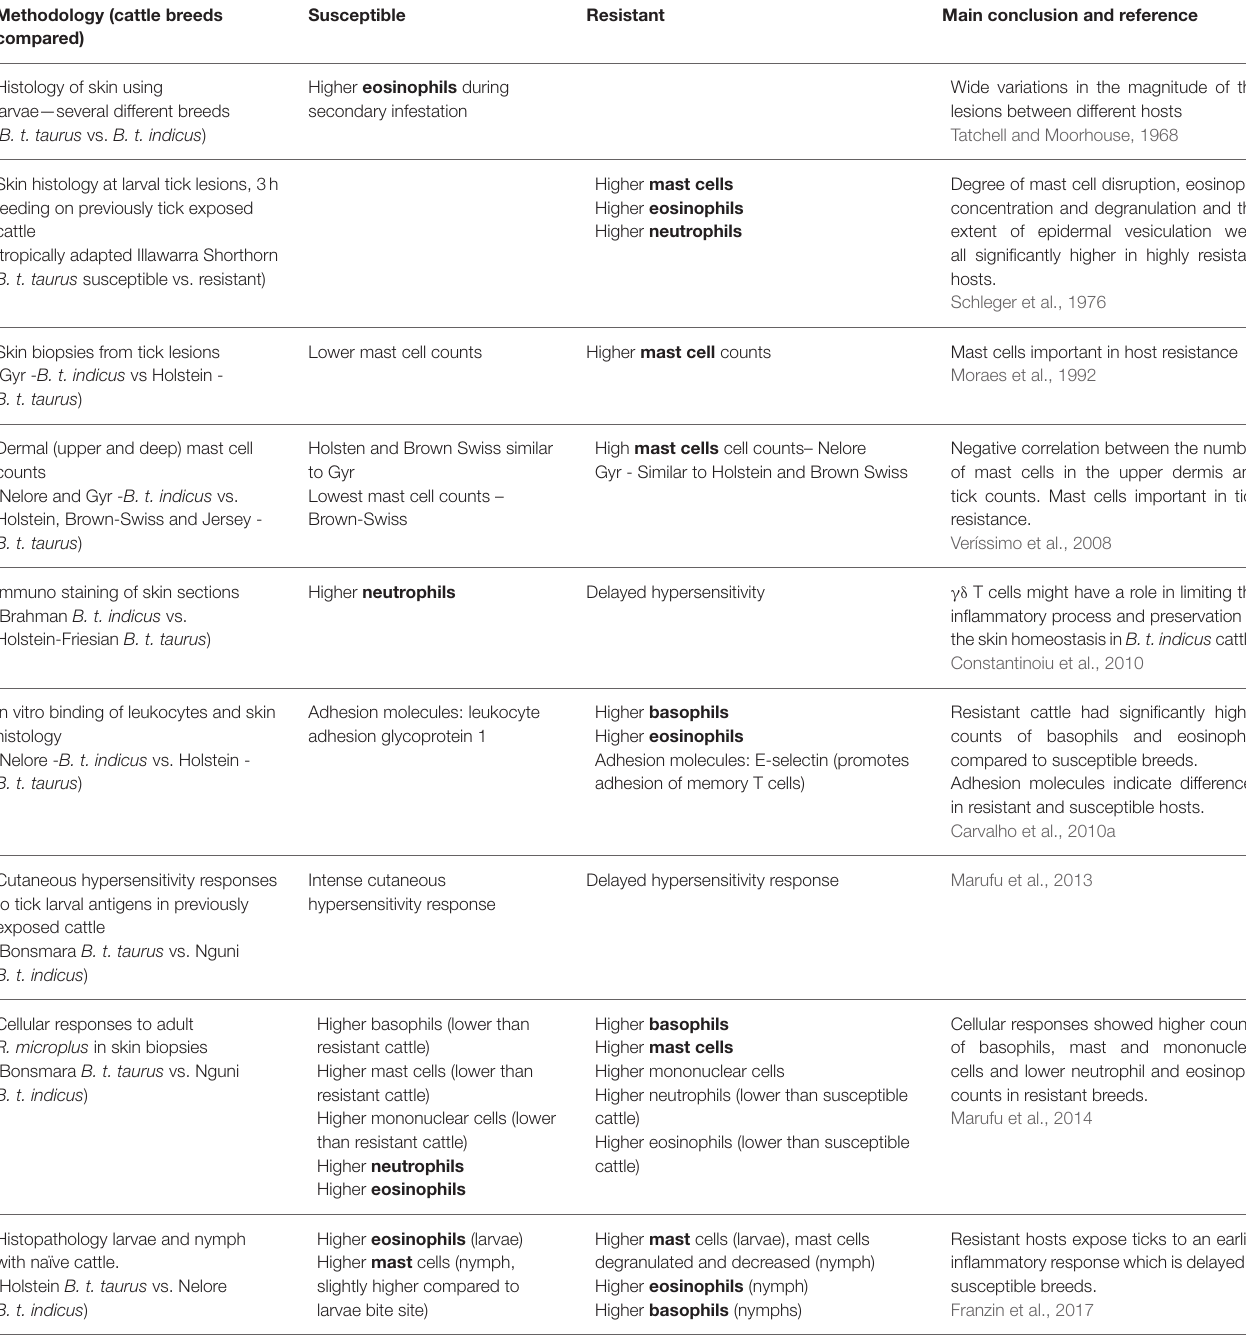
TABLE 2 | Summary of inflammatory profile between susceptible and resistant breeds of